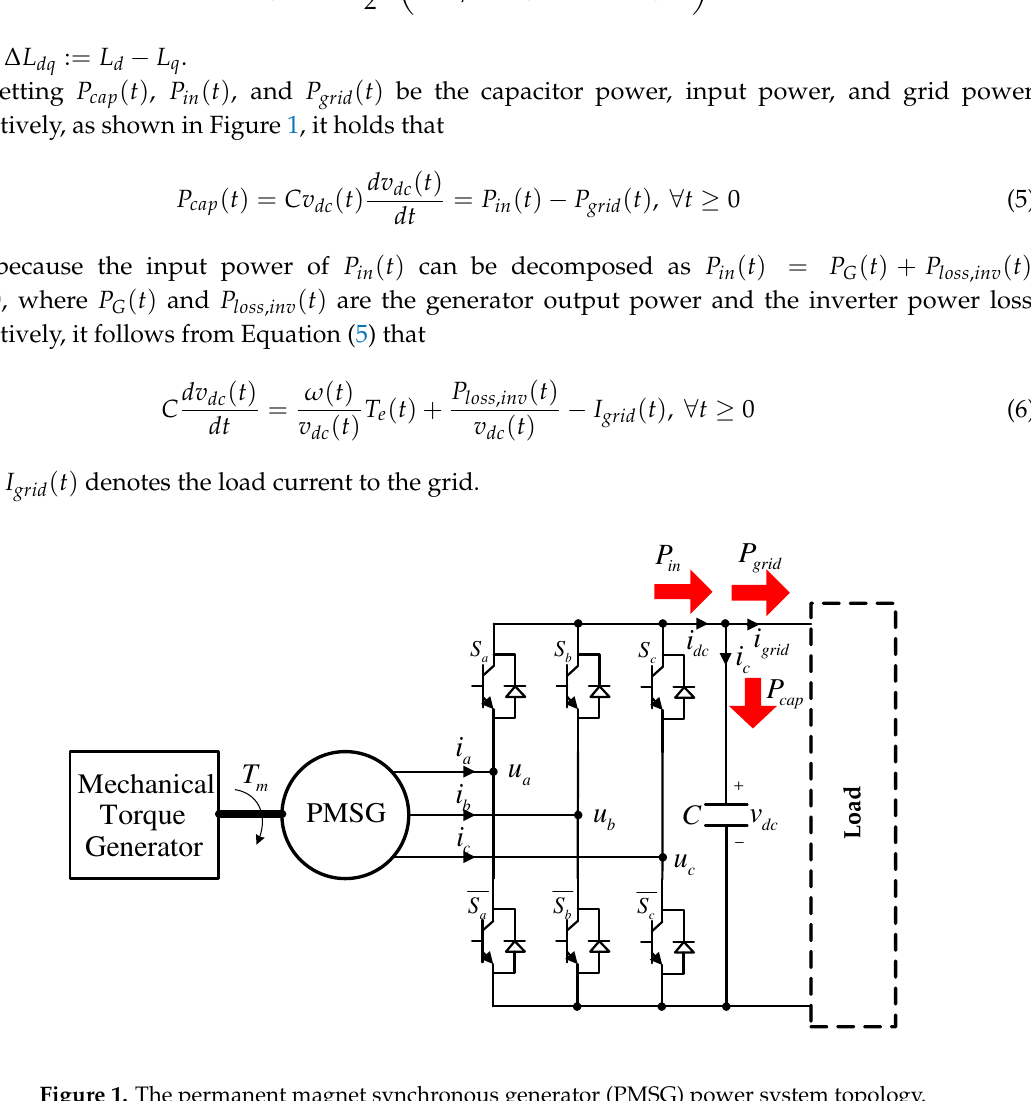
Figure 1. The permanent magnet synchronous generator (PMSG) power system